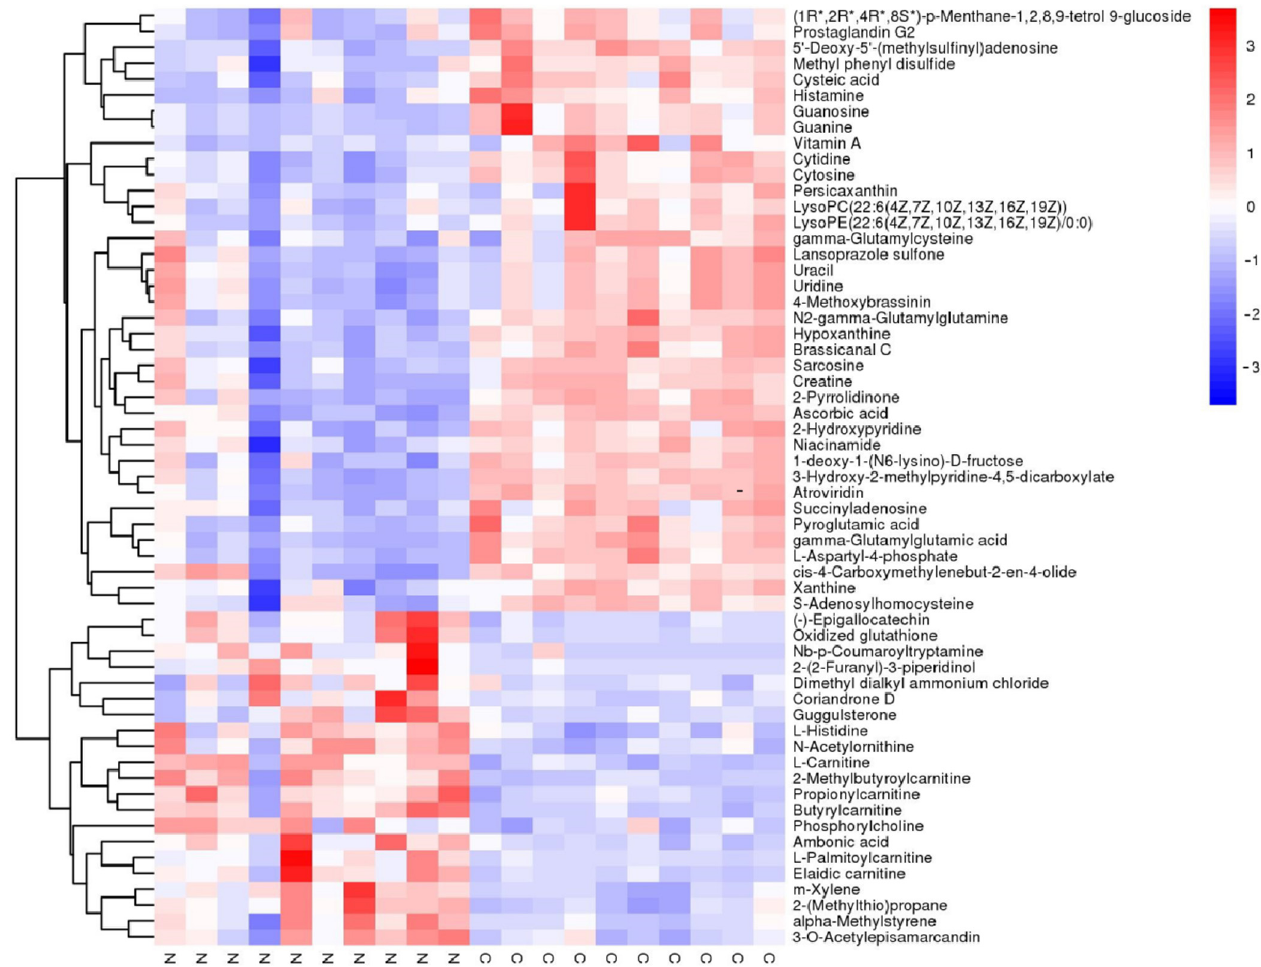
Figure 3. Heatmap of the different metabolites under the positive model in untargeted metabolomics. The blue color indicates the lower relative level of each metabolite, and the red color stands for the higher relative level of each metabolite. Table 2. Significantly altered metabolites under negative mode by untargeted metabolomics.